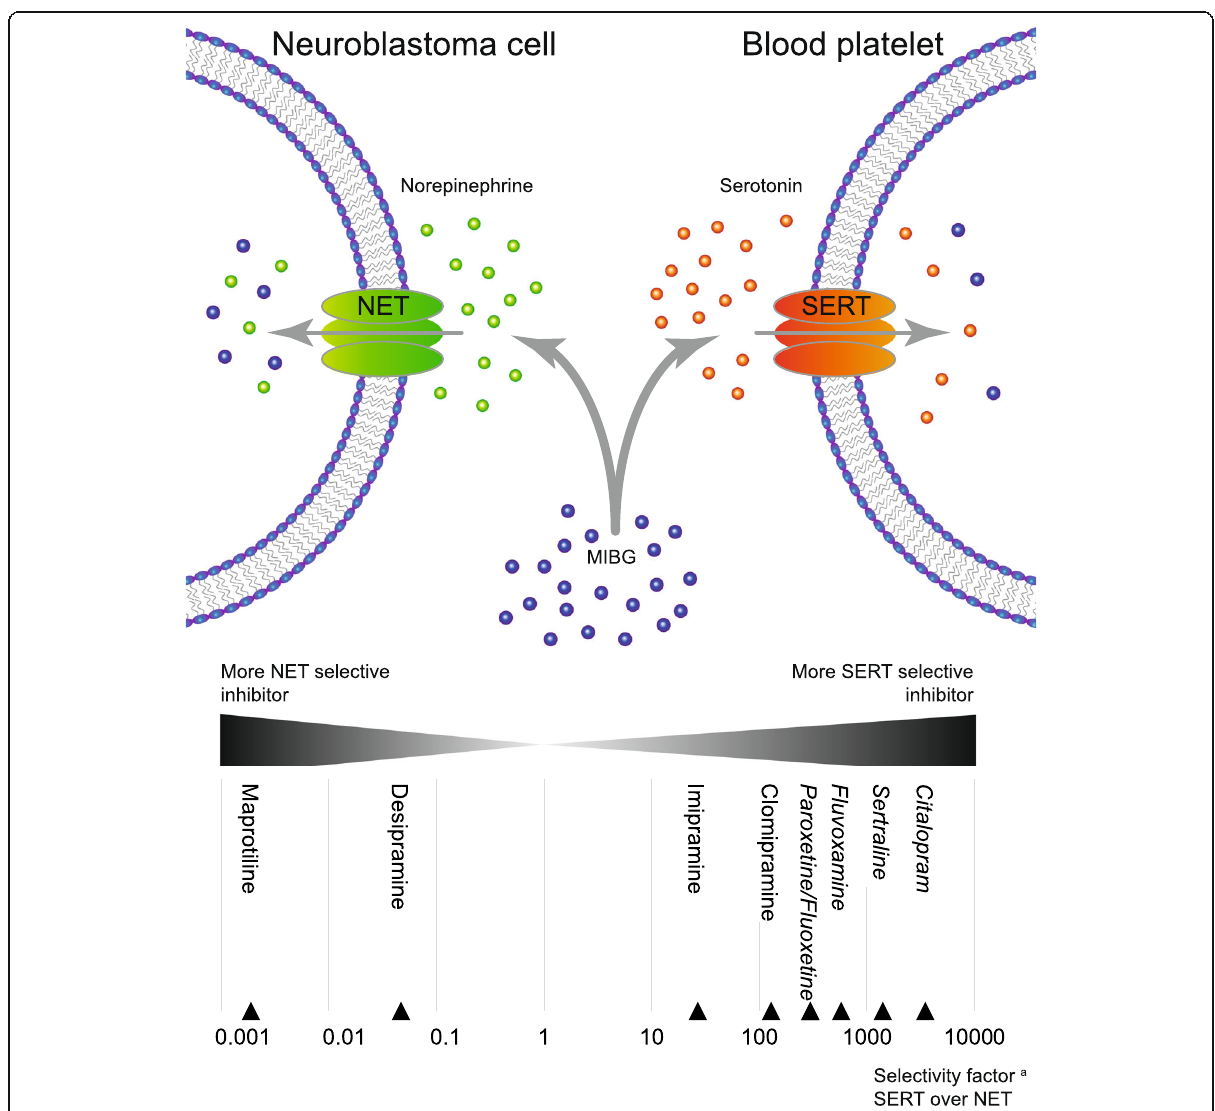
transport of MIBG (in blue). a For all monoamine transporter inhibitors, the selectivity factor was calculated from the ratio of the